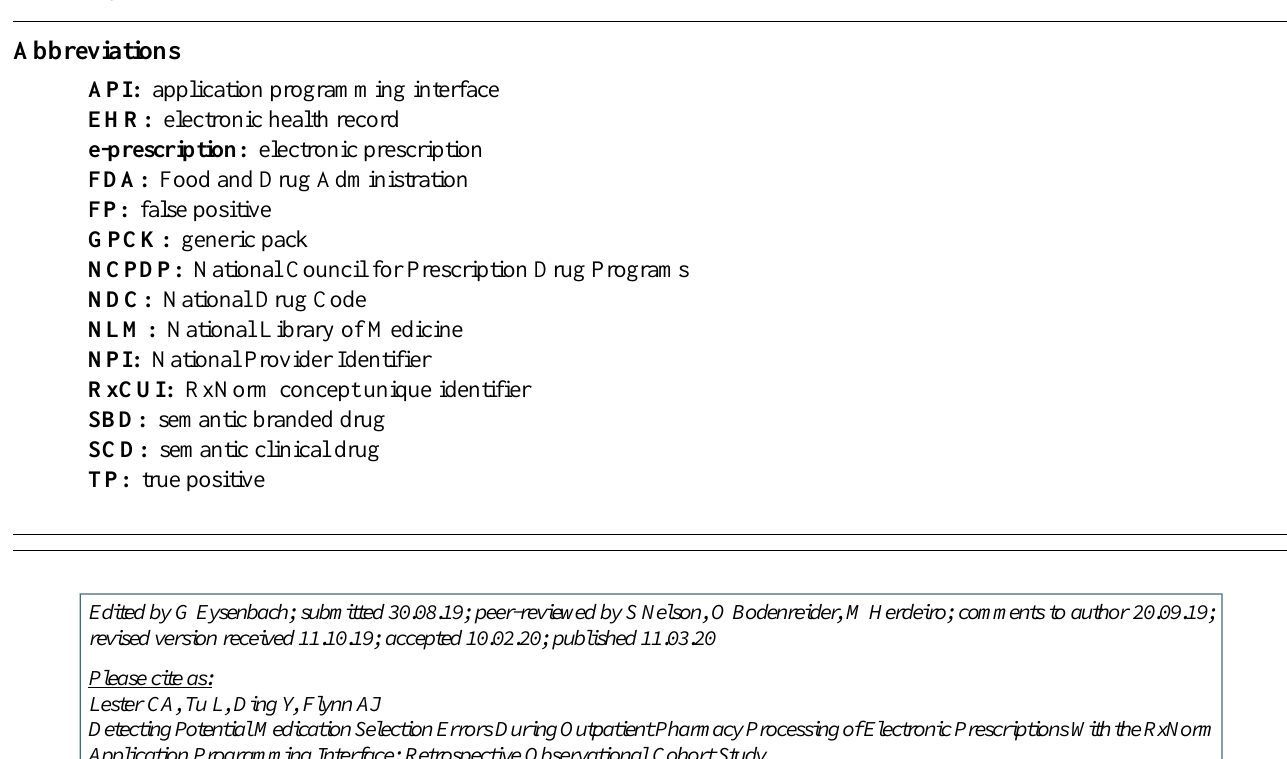
US Food and Drug Administration. CFR - Code of Federal Regulations Title 21 URL: